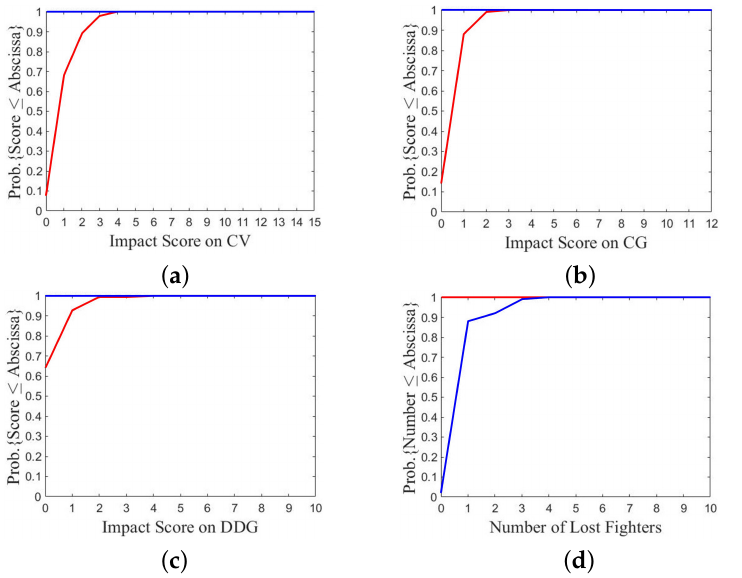
Figure 12. (A1/B3) Cumulative distribution of impact score on ( a ) CV ( b ) CG, ( c ) DDG, ( d ) fighters; over 100 games with one P 2 SO run, ———: fleet A, ———: fleet B.